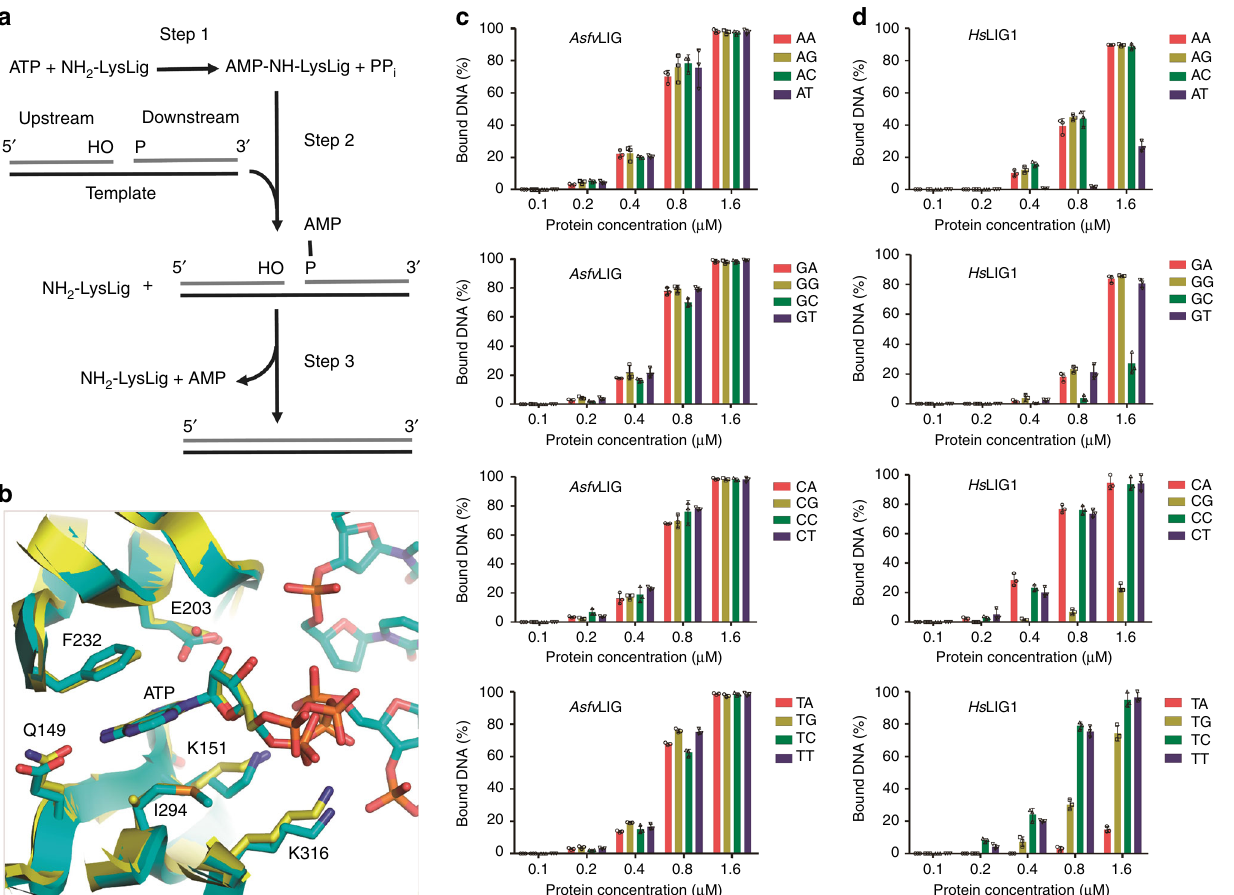
Fig. 7 Comparison of ATP and DNA binding by Asfv LIG and Hs LIG1. a The conserved catalytic mechanism of ATP-dependent DNA ligation. b Superposition showing the similar ATP binding observed in Asfv LIG and Hs LIG1 structures. Asfv LIG of the non-catalytic Asfv LIG:DNA complex is shown as cartoon in yellow, and ATP and ATP-interacting residues are shown as sticks in atomic colors (C, yellow; N, blue; O, red; P, orange). Hs LIG1 in the complex with adenylated DNA (PDB_ID: 1 × 9 N) is shown as cyan cartoon. DNA, AMP, and AMP-interacting residues of Hs LIG1 are shown as sticks in atomic colors (C, cyan; N, blue; O, red; P, orange). c In vitro DNA binding by Asfv LIG1. d In vitro DNA binding by Hs LIG1. All data points from three independent experiments are shown with the median expressed as bars. The standard deviation (±SD) values are indicated by error